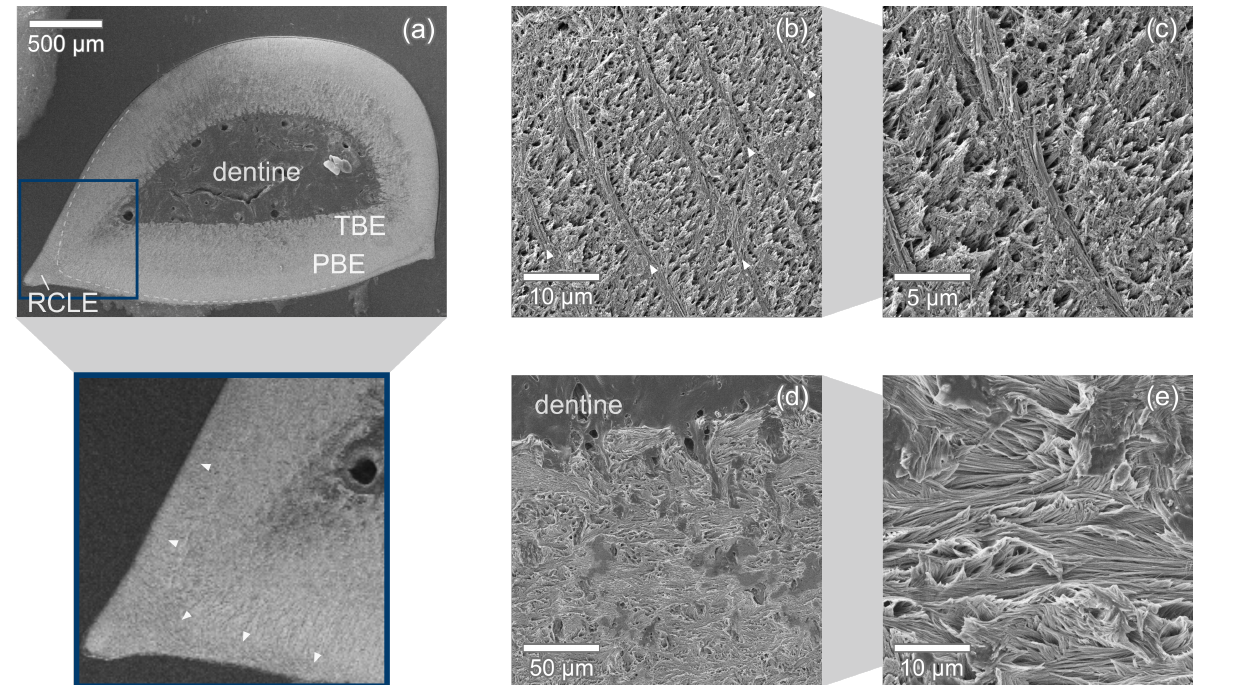
Figure 4. Transversal section of I. oxyrinchus tooth. The tooth’s enameloid cover is built up in layers ( a ). The outer enameloid is designated RCLE and clearly separated (dashed line, arrow heads in zoomed-in view) from the inner enameloid consisting of PBE and TBE. ( b , c ) show the outer edge of the enameloid cover and radial elements (arrow heads) running towards the outer enameloid. In between the radial elements, bundles are oriented parallel to the tooth’s longitudinal axis. ( d , e ) show three-dimensional entanglement of bundles close to the dentine-enameloid junction.